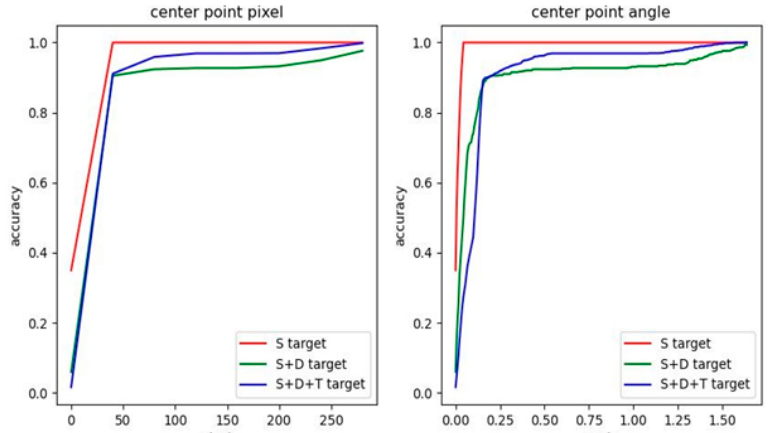
Figure 12. Center-point position offset pixels and offset angles in different accuracy ranges.